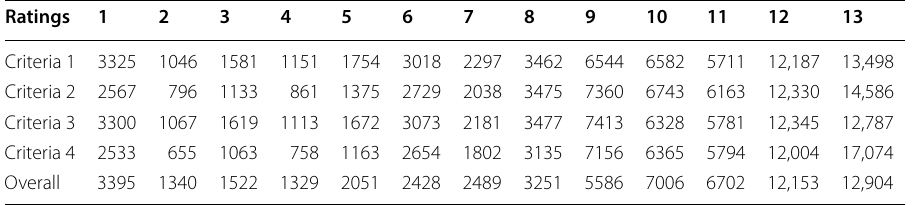
Table 4 Movies dataset ratings distribution